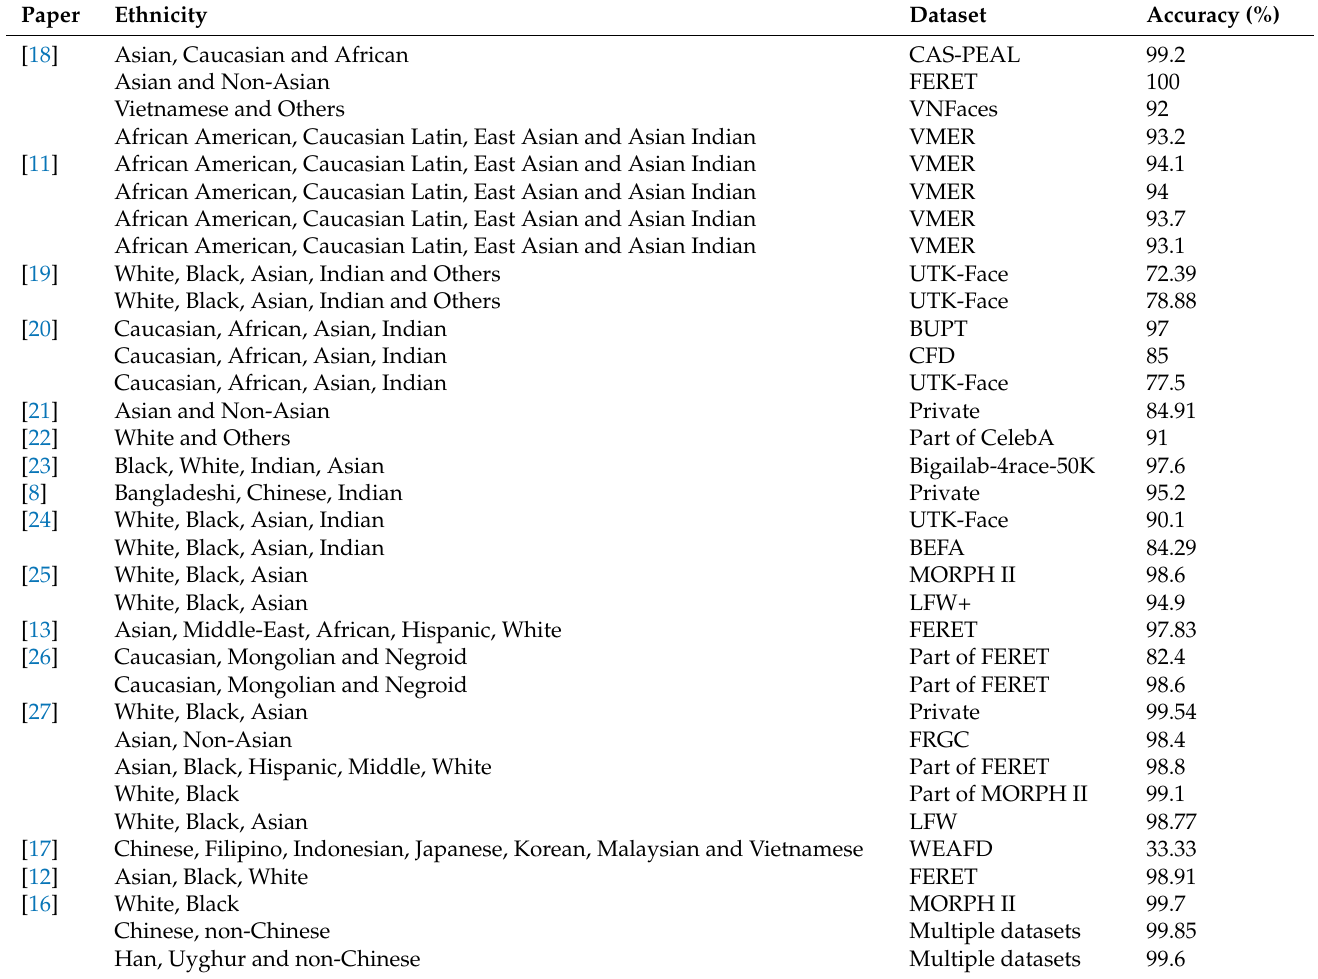
Table 19. Accuracy of state-of-the-art models for ethnicity